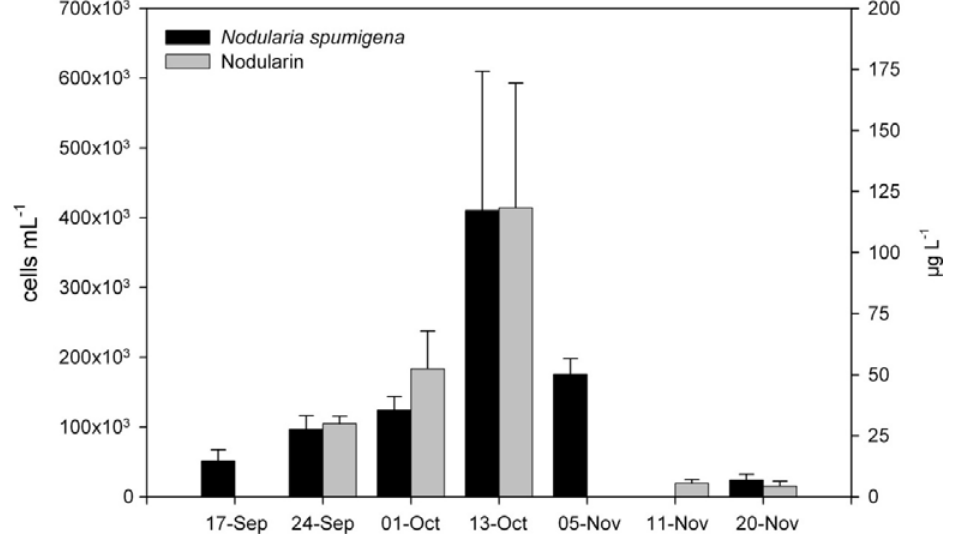
Figure 2. Temporal changes in Nodularia spumigena cell concentration and nodularin concentration in Carbrook Cable Ski Lake during the bloom period (mean +